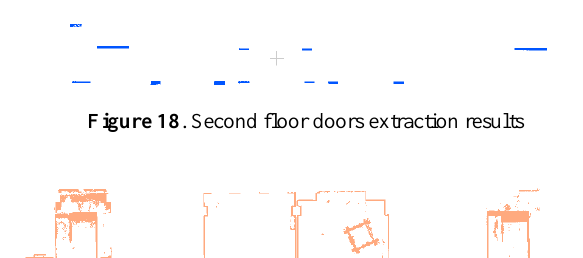
Figure 19. First floor door extraction results